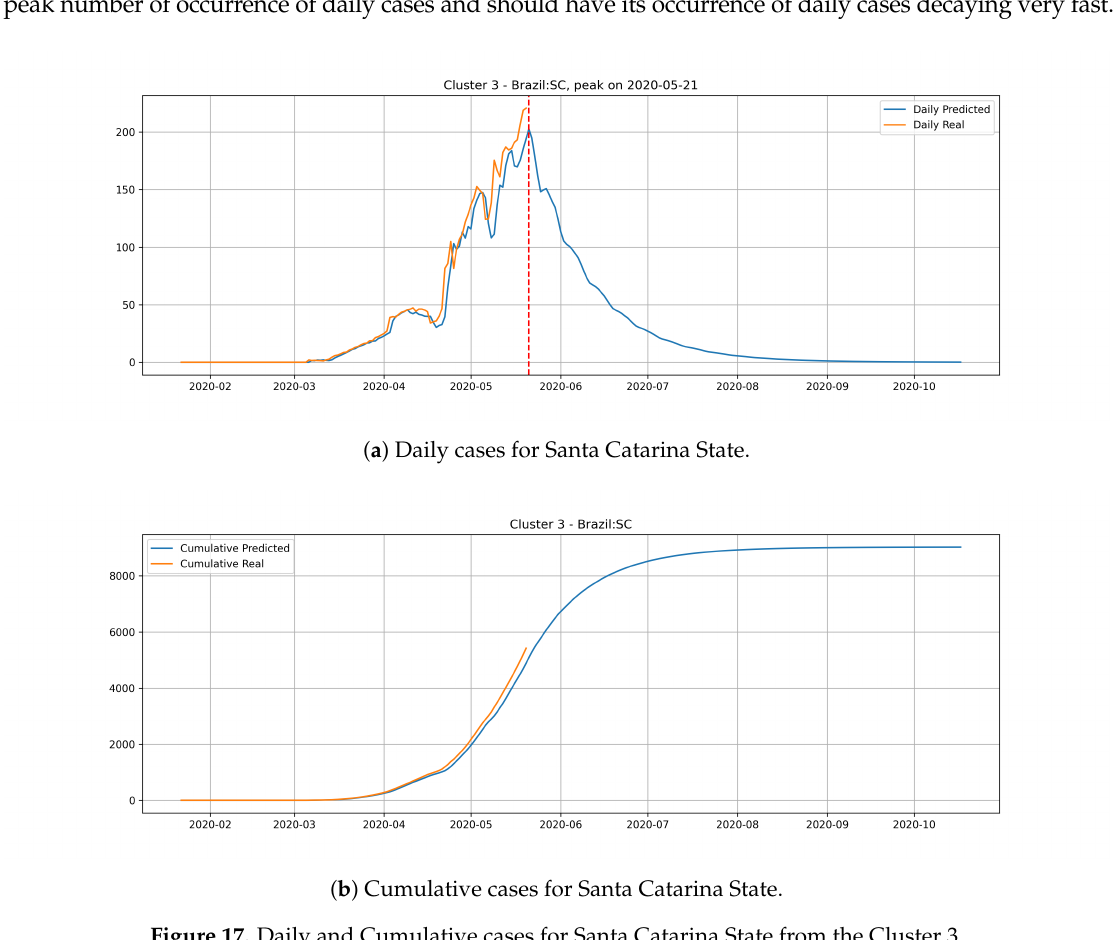
Figure 17. Daily and Cumulative cases for Santa Catarina State from the Cluster